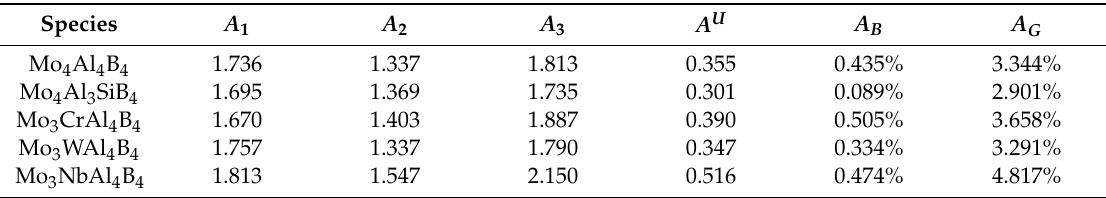
Table 4. The calculated anisotropic indexes of MoAlB crystals